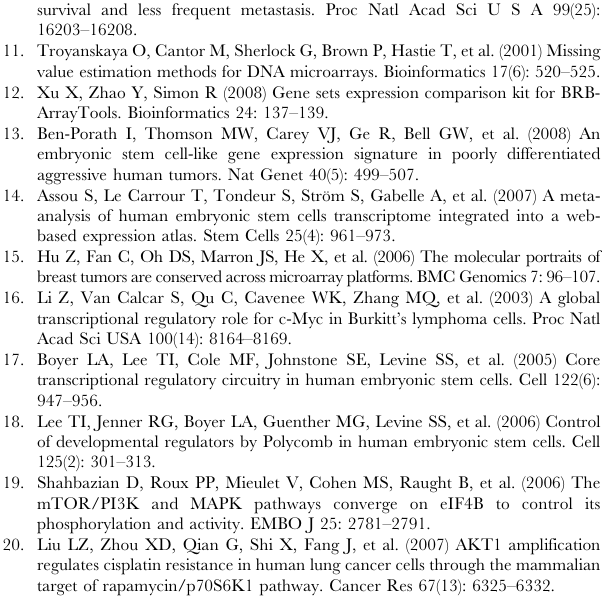
Figure S1 A modified Kegg pathway diagram for mTOR signature are shown in bold.